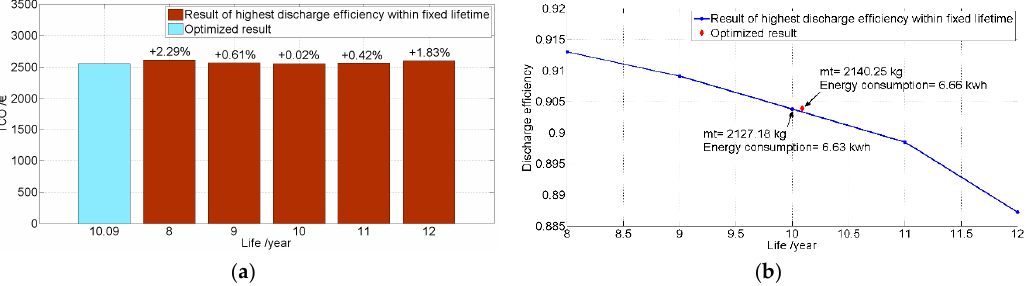
Figure 10. The comparison of TCO with the highest discharge efficiency and varying fixed lifetime. ( a ) The comparison of TCO; ( b ) The varied discharge efficiency.